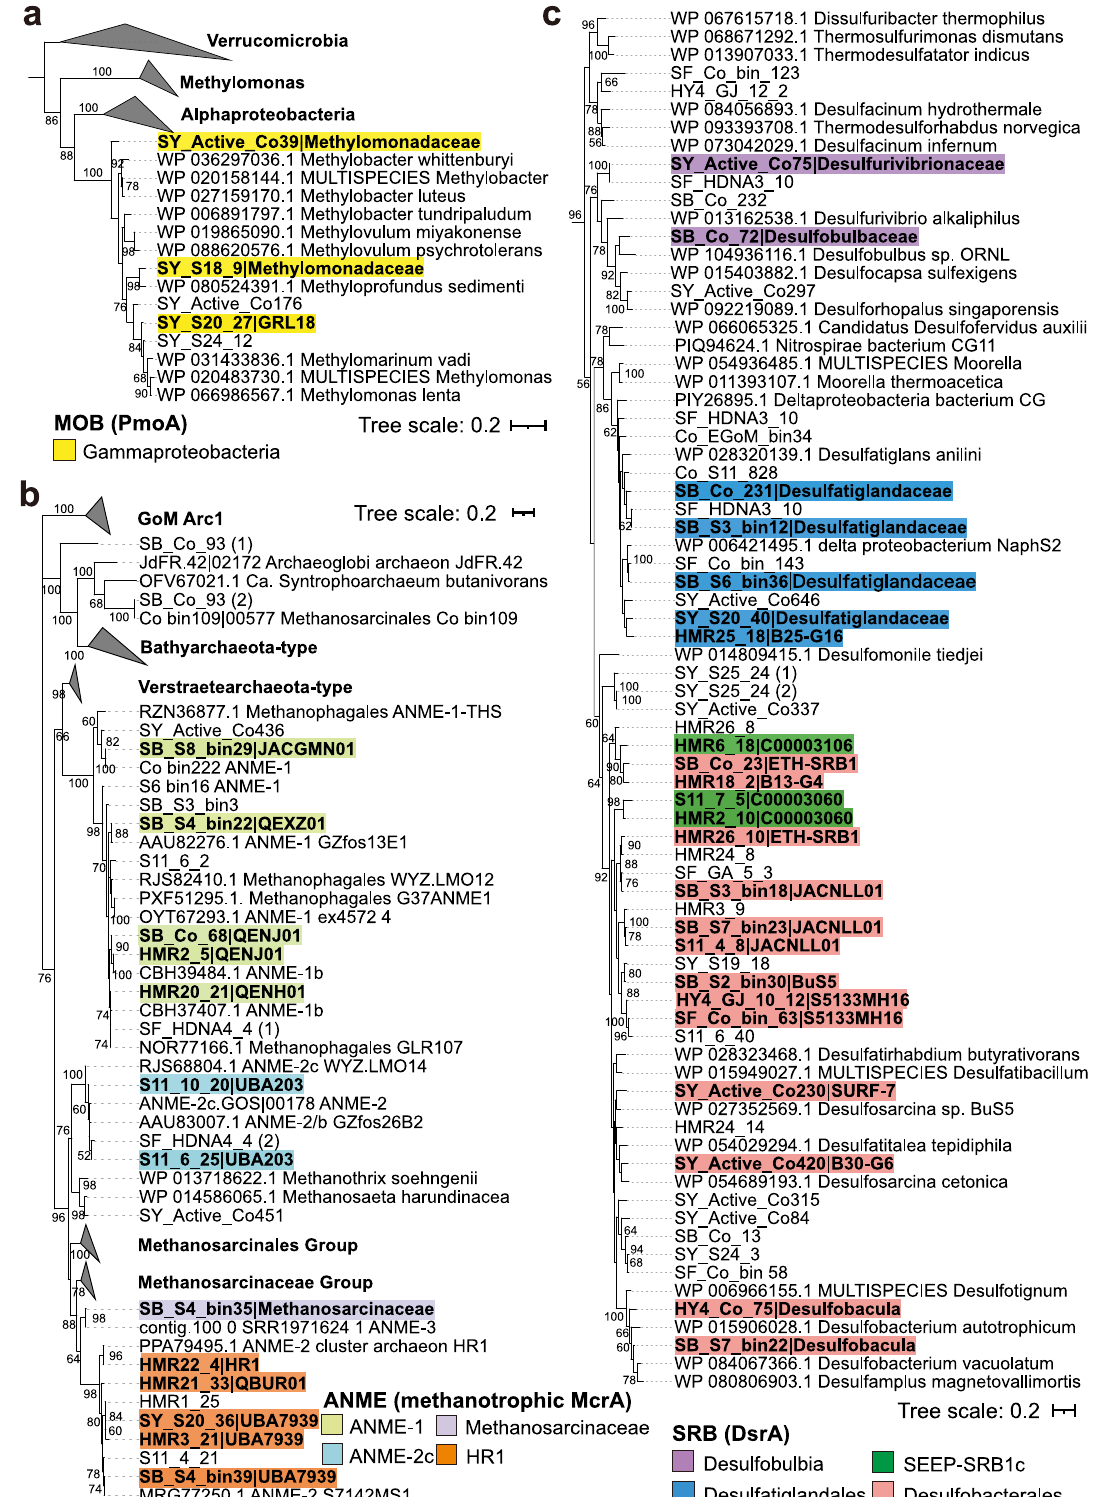
Fig. 2 | Maximum-likelihood phylogenetic trees of three key functional enzymes in cold seep sediments. Phylogenetic trees are based on amino acid alignments for a PmoA, b methanotrophic McrA, and c DsrA protein sequences. The sequences from the same taxonomic groups (class, order, or family level) are highlighted in the same colors. The taxonomic information of each sequence is